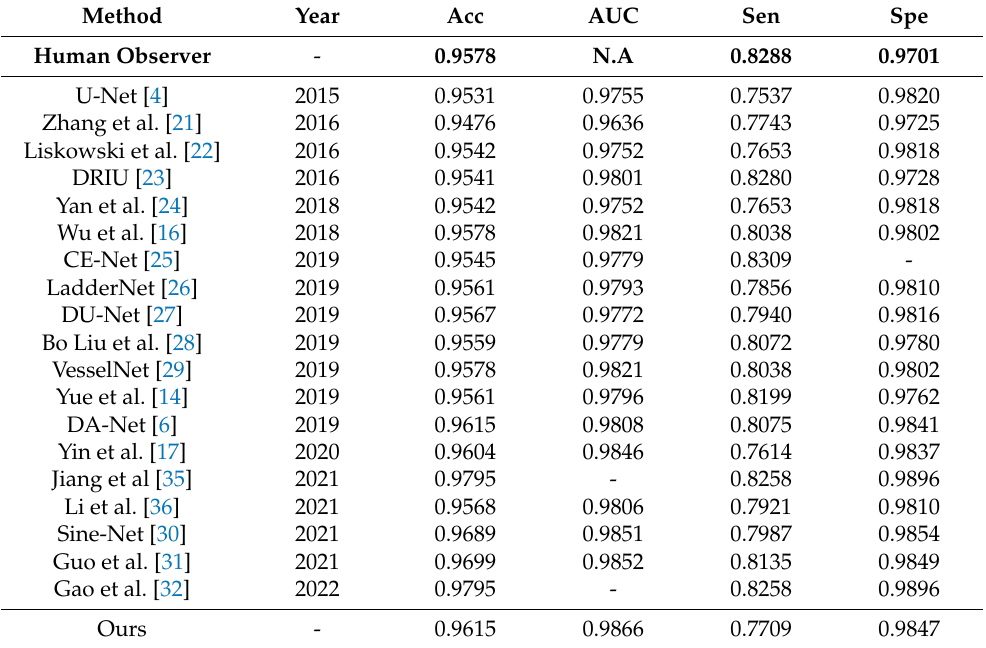
Table 1. Segmentation performance for DRIVE inside